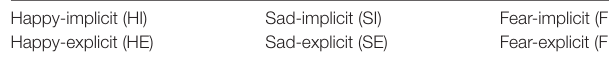
TABLE 1 | Listening conditions in fMRI study. Happy-implicit (HI) Sad-implicit (SI) Fear-implicit (FI) Happy-explicit (HE) Sad-explicit (SE) Fear-explicit (FE)